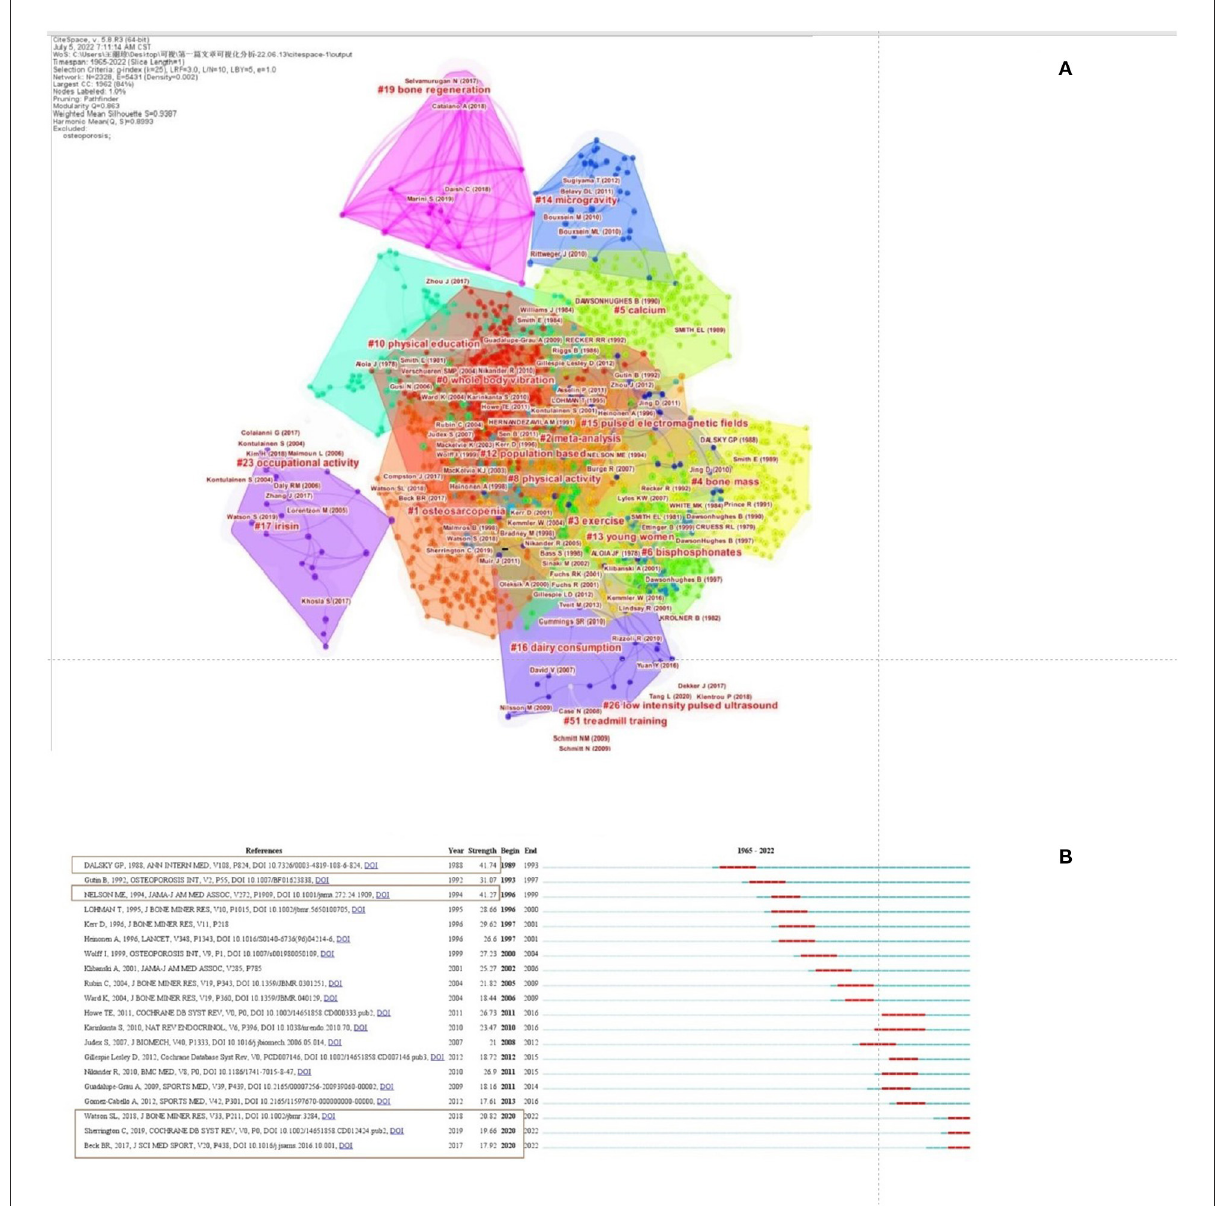
FIGURE6 Co-citation clustering of osteoporosis rehabilitation studies (A) . The top 20 references with the strongest citation bursts on osteoporosis rehabilitation research (B)